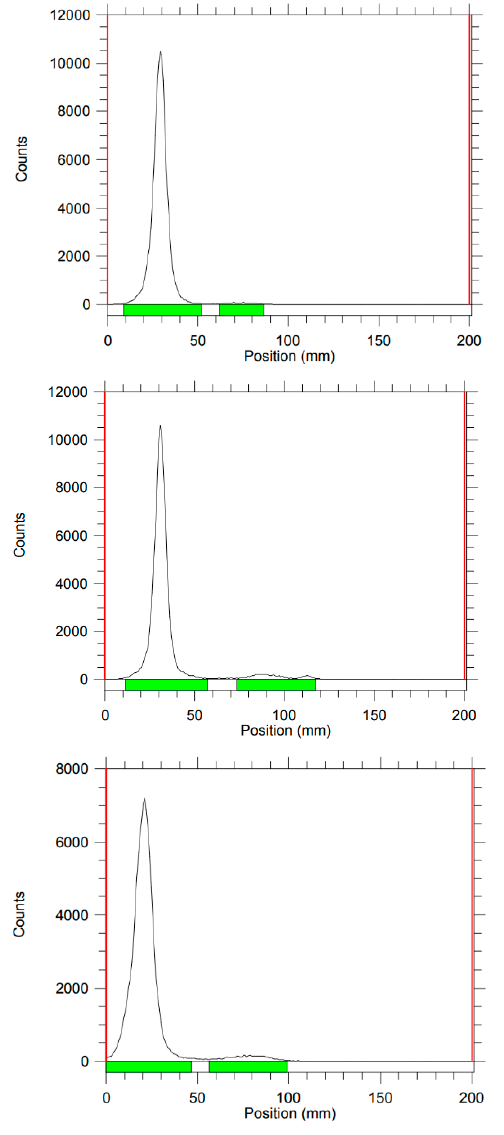
Figure 1. iTLC chromatograms of samples 1–5 .